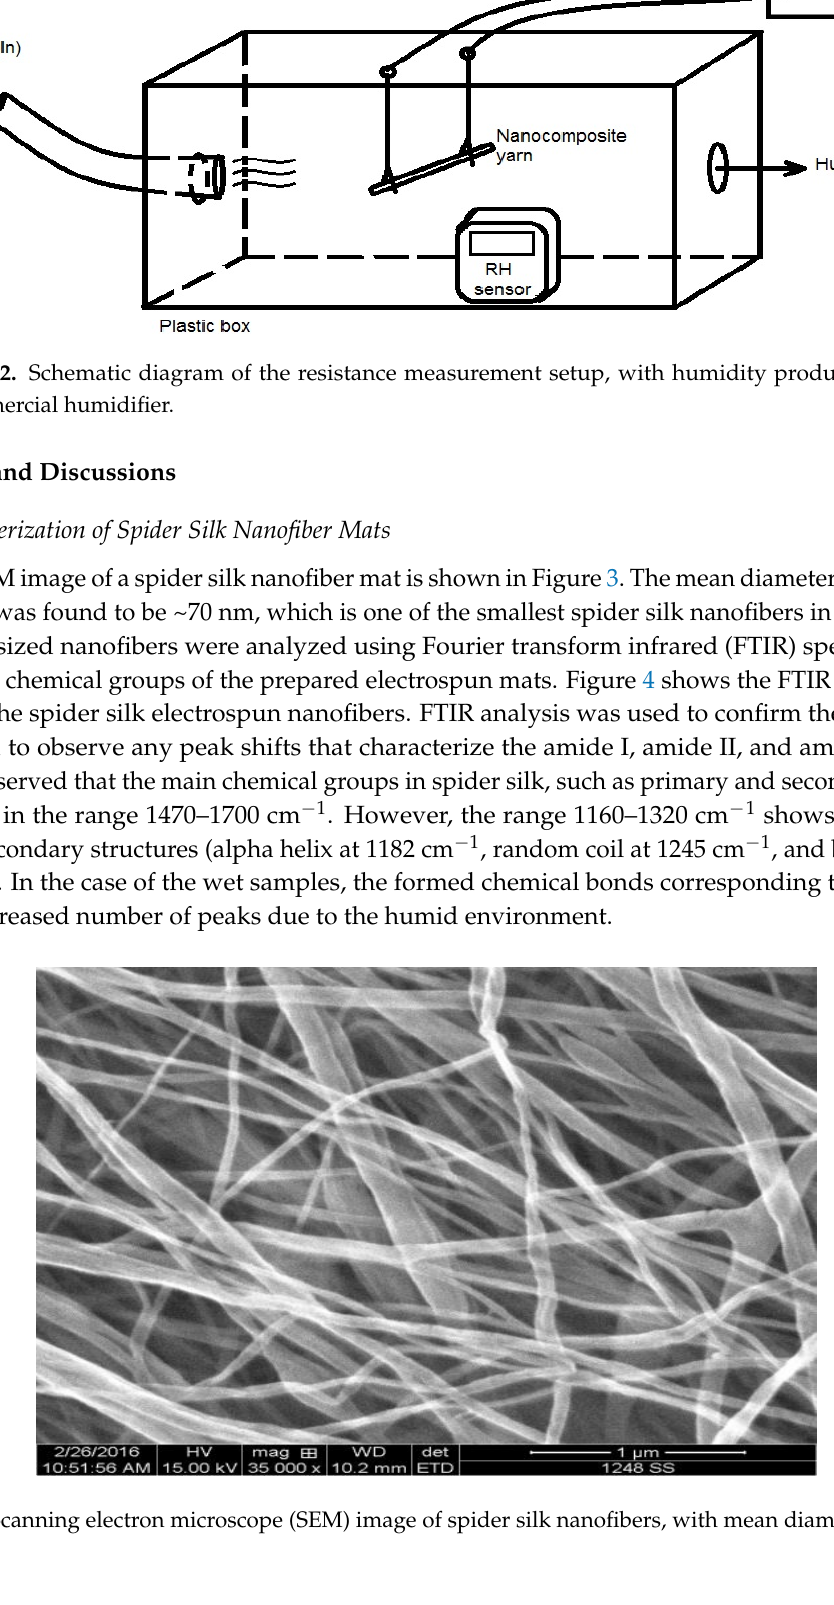
Figure 2. Schematic diagram of the resistance measurement setup, with humidity produced with a